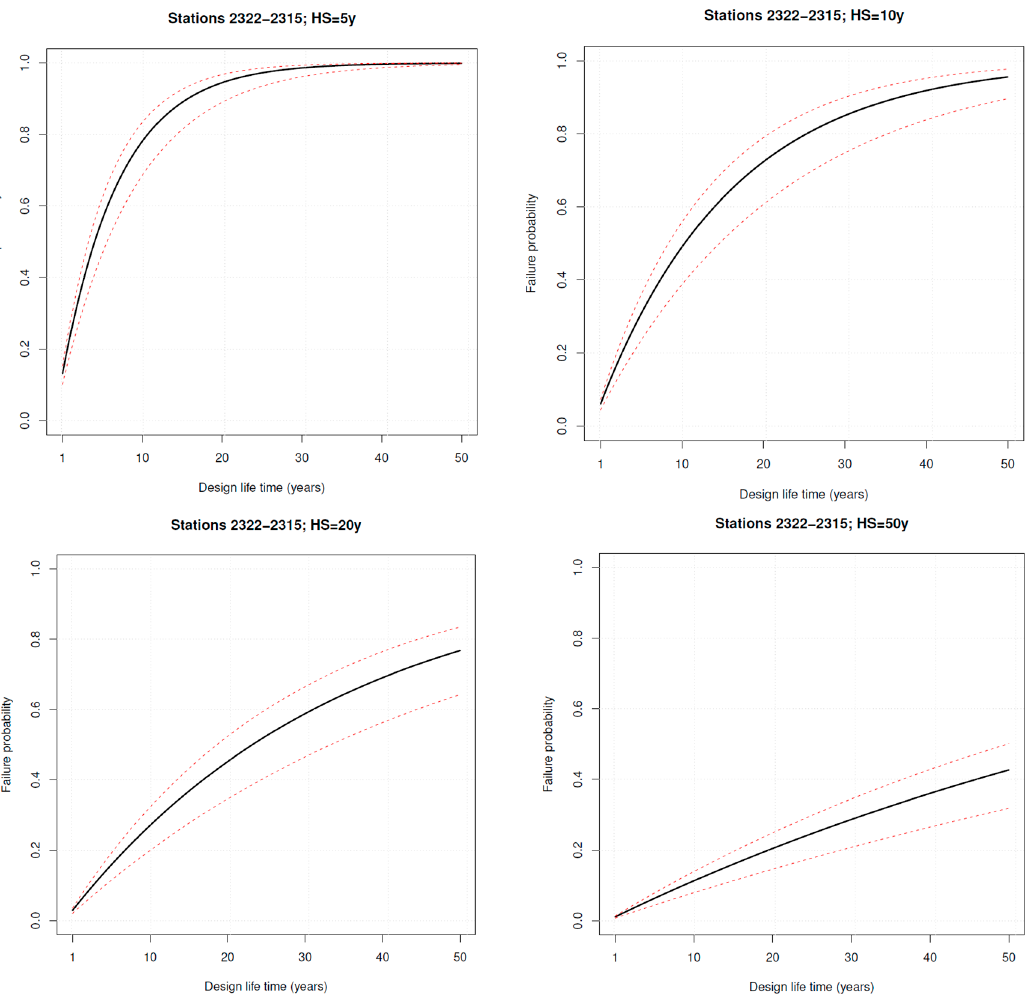
Figure 13. Lower Çoruh basin. Failure probabilities for given design life times; the dashed red lines indicate a 95% confidence band. The different plots correspond to the probability that the system enters a bivariate AND hazard scenario whose marginal critical thresholds are given by the quantiles reported in Table 5, corresponding to different return periods indicated in the main titles—see text.